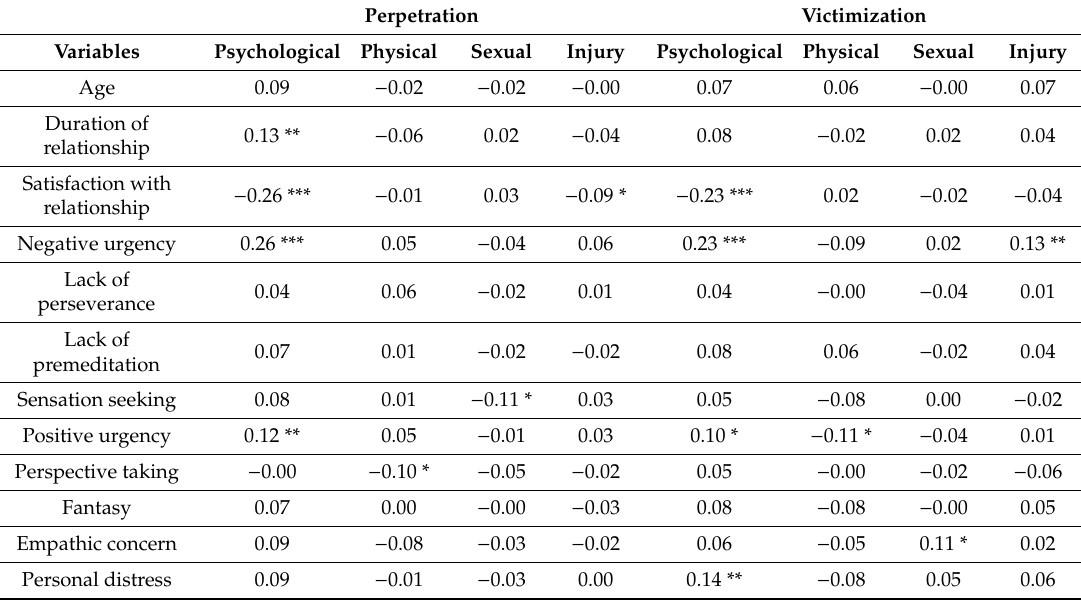
Table 2. Intercorrelation of all predictor variables with dating perpetration and